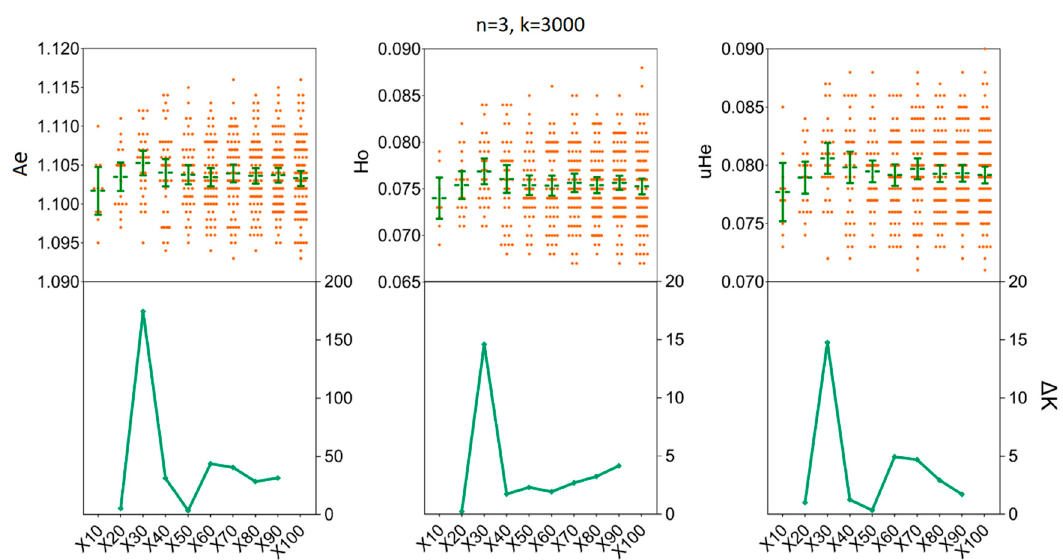
Figure 3. The minimum number of resampling replicates (x) required to estimate the genetic diversity in LNSY population. Bars represent sample means and 95% confidence intervals of the means. The Δ K ( Y -axis) shows a clear peak at the optimal replicates (x). Ae , number of effective alleles; Ho, observed heterozygosity; uHe , unbiased expected heterozygosity.